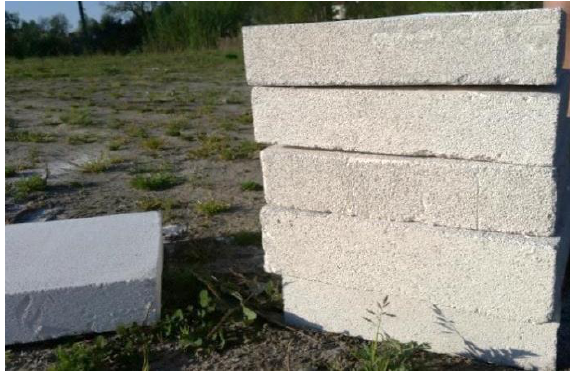
Fig. 6. Aerated concrete block samples for thermal conductivity test: Aeroc Classic 300 and RocLITE UNIVERSAL